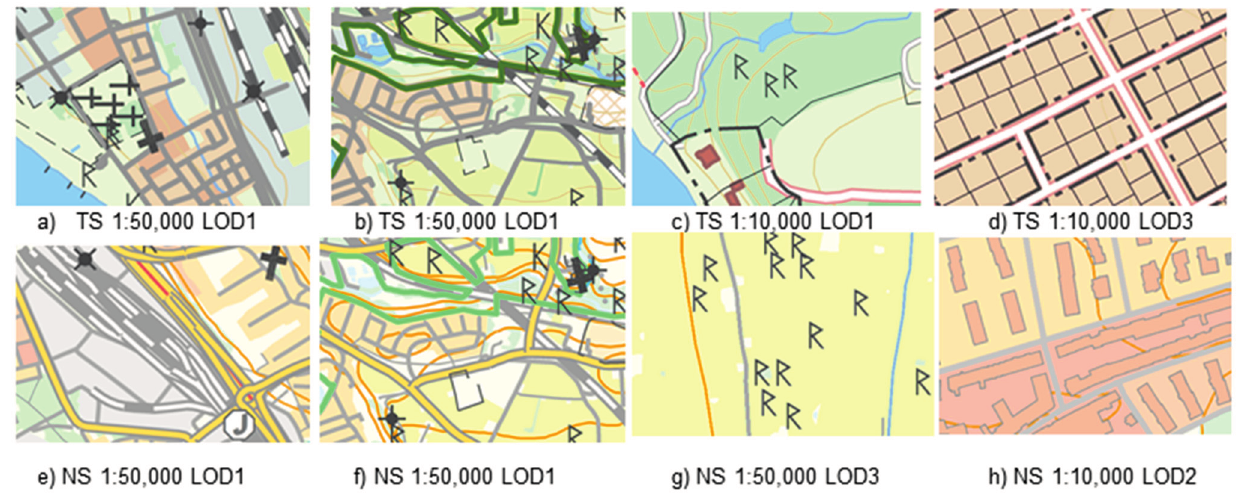
Figure 1. Eight map samples ( a – h ) used in the study. The maps are presented with two symbol styles (NS and TS) at two scales (1:50,000 and 1:10,000) and at three levels of detail ((LOD) 1–3). Maps b and f only differ in symbol